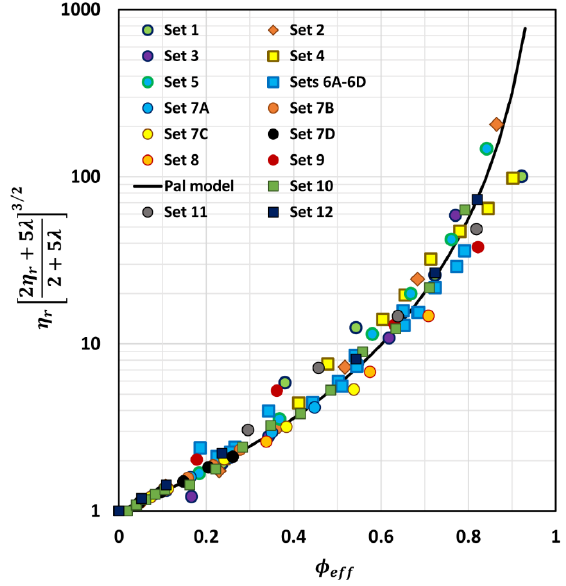
Figure 23. Comparison of experimental viscosity data for emulsions of non-Brownian droplets with the prediction of the proposed model, Equation (44) ( φ m varies from one set to another in the range of 0.637 to 0.7404).